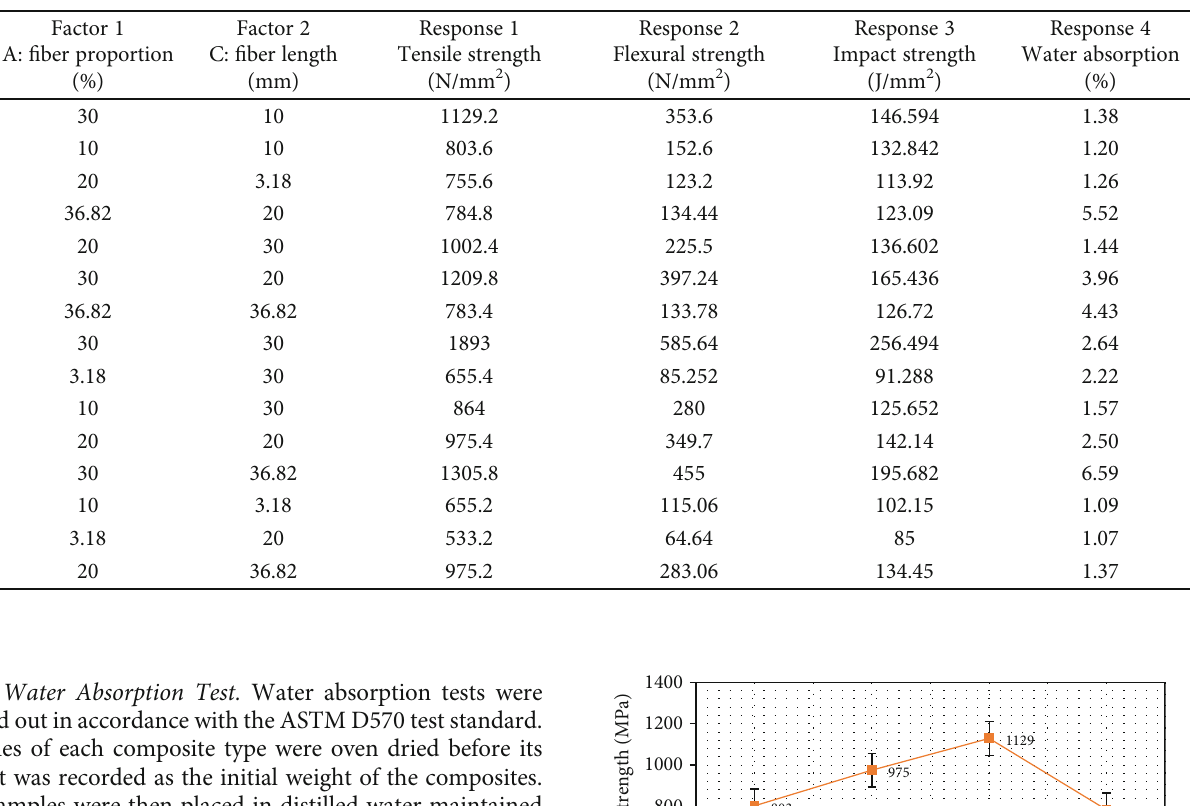
Table 2: Properties of the manufactured composite.